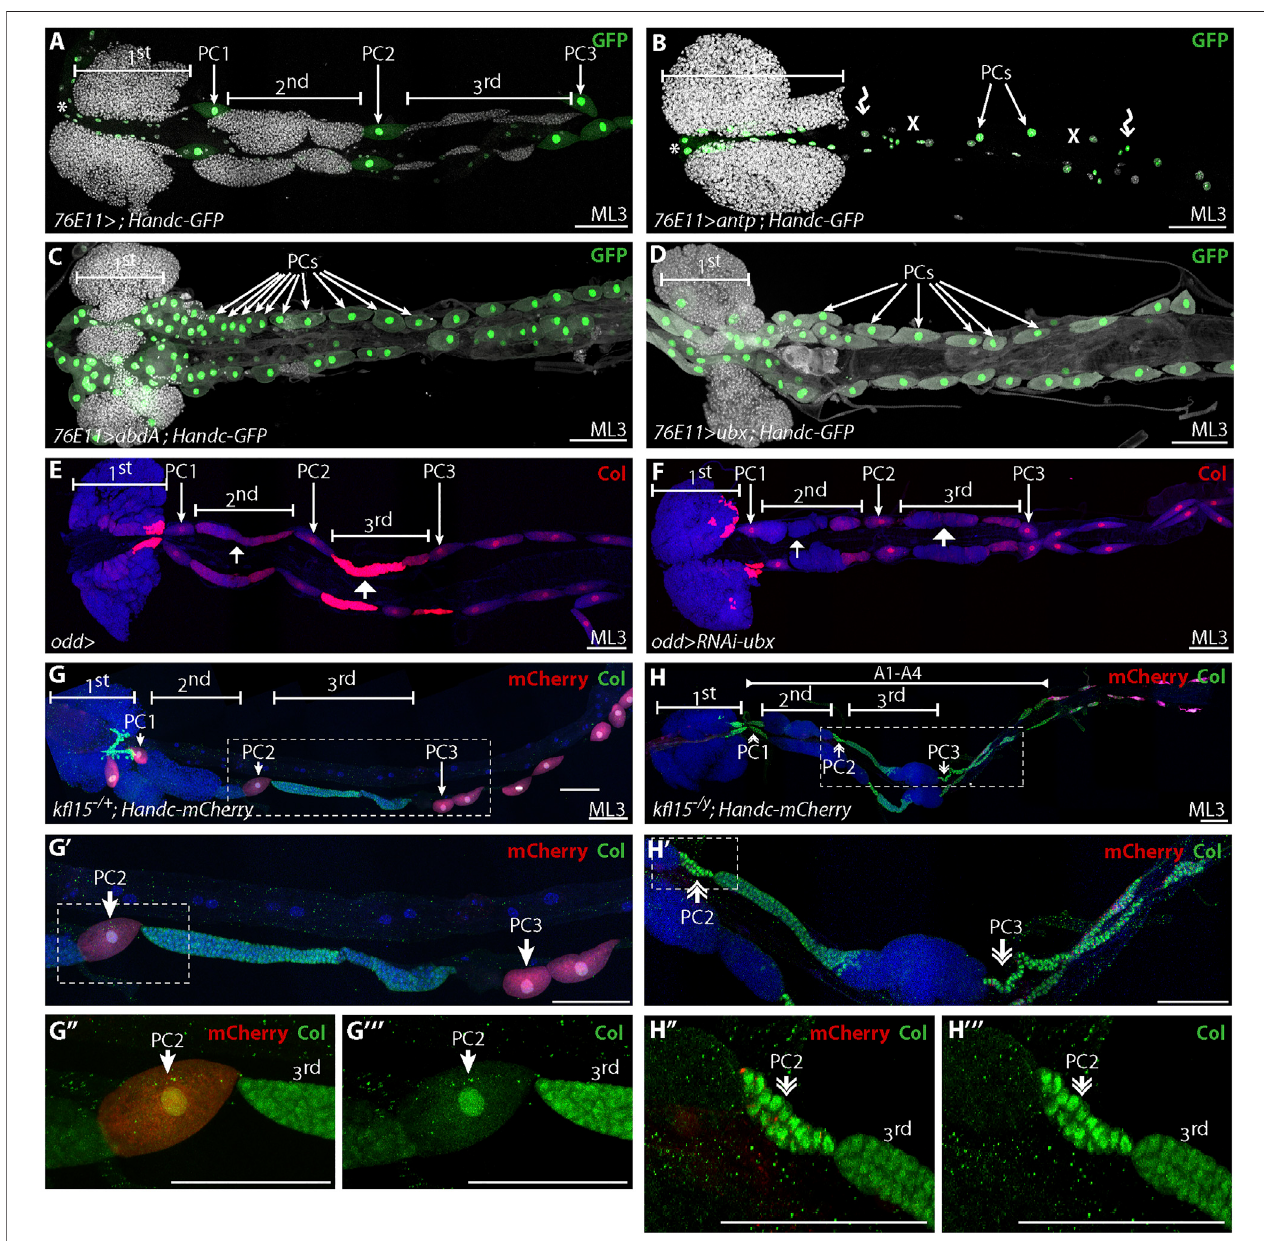
FIGURE 5 | Ubx and Klf15 required at larval stage to regulate blood cell and nephrocyte fate (A – D) Mid L3 larvae (ML3) lymph glands expressing Handc-GFP (green),whichlabelscardiac(*)andpericardialcells(whitearrow),withthe 76E11-Gal4 driver,andDapi(white)labelsnuclei. (B) antp overexpressionleadstolossofboth posteriorlobes(wavyarrow)andmostpericardialcells(X). (C) abdA or (D) ubx overexpressionleadstolossofposteriorlobes,togetherwithformationofsupernumerary larval pericardial cells (PCs). (E,F) Col (red) immunostaining in the control (E) and when ubx is knocked down in pericardial cells, with the odd-Gal4 driver (F) . No difference inpericardialcellsand posterior lobeformationisobservedcompared tothecontrol. Col expression (smalland largewhitearrows) hasdecreasedin posterior lobes compared to the control. (G,H ”’ ) Mid L3 lymph gland of control Klf15/+ (G-G ”’ ) and Klf15 mutant [ Klf15/Y, (H-H ”’ ) ]. Col expression in green, Handc-mcherry which labels larval pericardial cells in red, and Dapi in blue labels nuclei. (G ’ ,H ’ ) are enlargements of G and H , respectively. (G ” ,G ”’ ,H ” ,H ”’ ) are enlargements of (G ’ ,H ’ ) , respectively. Klf15 mutant (H-H ”’ ) pericardial cells are abnormal and resemble novel posterior lobes, while second and third lobes resemble the control (G-G ”’ ) . In the posterior aorta (A1-A4) of Klf15 mutant larvae, pericardial cells are transformed into blood cells (double arrowhead), expressing high levels of Col without expressing Handc-mCherry, a marker for pericardial cells.